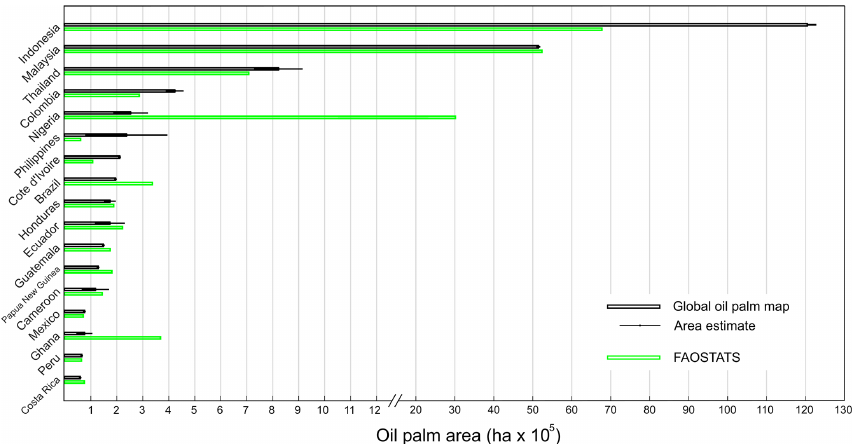
Figure A7. Oil palm surface per country generated with the global oil palm map (2019) and extracted from the FAOSTAT “harvested area” for the year 2018. The error bar in the global oil palm map shows the confidence interval with a confidence level of 95%.